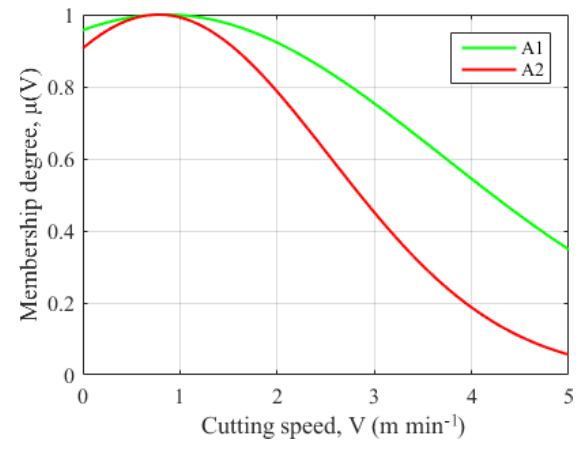
Figure 9. Gaussian MFs of input V